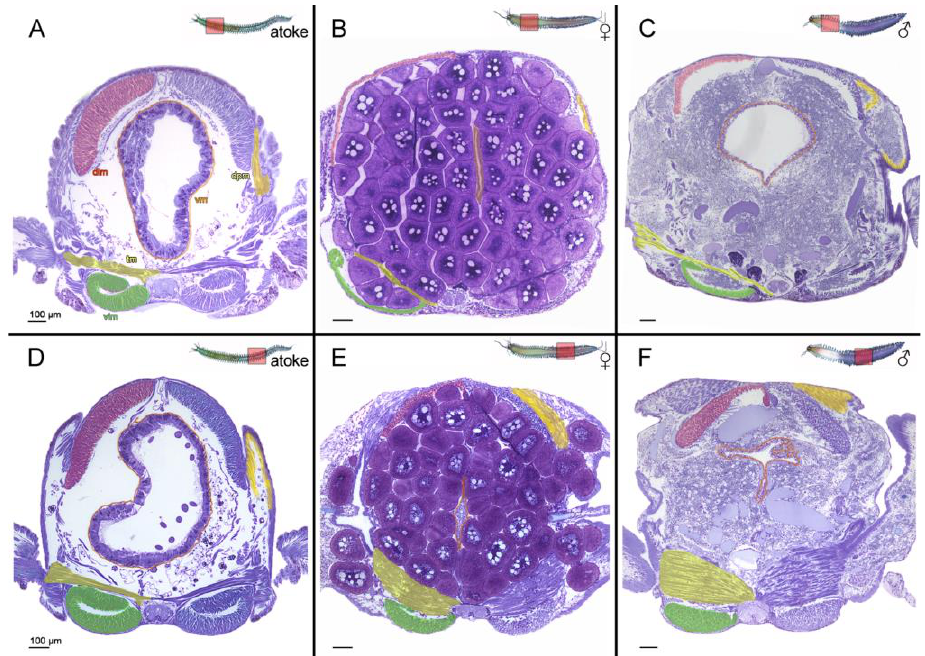
Figure 1. Changes in the morphology of the somatic muscles in the anterior and posterior segments after sexual maturation. ( A – F ) Cross-sections of whole Platynereis segments displaying all muscles types in immature atokous ( A , D ), in female epitokous ( B , E ), as well as in male epitokous animals ( C , F ). ( A – C ) Anterior and ( D – F ) posterior-located segments of the same worm. ( A , D ) The atokous musculature consists of a thin outer layer of circular muscles (not labeled), the dorsal (dlm red) and ventral longitudinal muscles (vlm green), the transversal muscles (tm yellow), the dorsal parapodial muscles (dpm light yellow), and the visceral musculature surrounding the midgut (vm orange), each marked in one hemisegment. ( B , C , E , F ) Beside the formation of the respective germ cells, the degeneration of the midgut is obvious after the maturation. Longitudinal and transversal muscles are differently remodeled during metamorphosis in dependency to their anterior-posterior position along the body axis. ( A – C ) In anterior segments, the dlm and vlm muscles are strongly reduced in thickness and appear much less compact at the end of maturation, while transversal muscles appear unchanged. ( D – F ) The dlm and vlm muscles are also reduced in posterior segments, but to a lesser degree. Whereas, in contrast, the transversal muscle complex appears to be very thickened and swollen, and displays an inflated and thus hypertrophied overall morphology. Abbr.: dlm dorsal longitudinal muscles, dpm dorsal parapodial muscles, tm transversal muscles, vlm ventral longitudinal muscles, vm visceral muscles. Scale bars = 100 µ